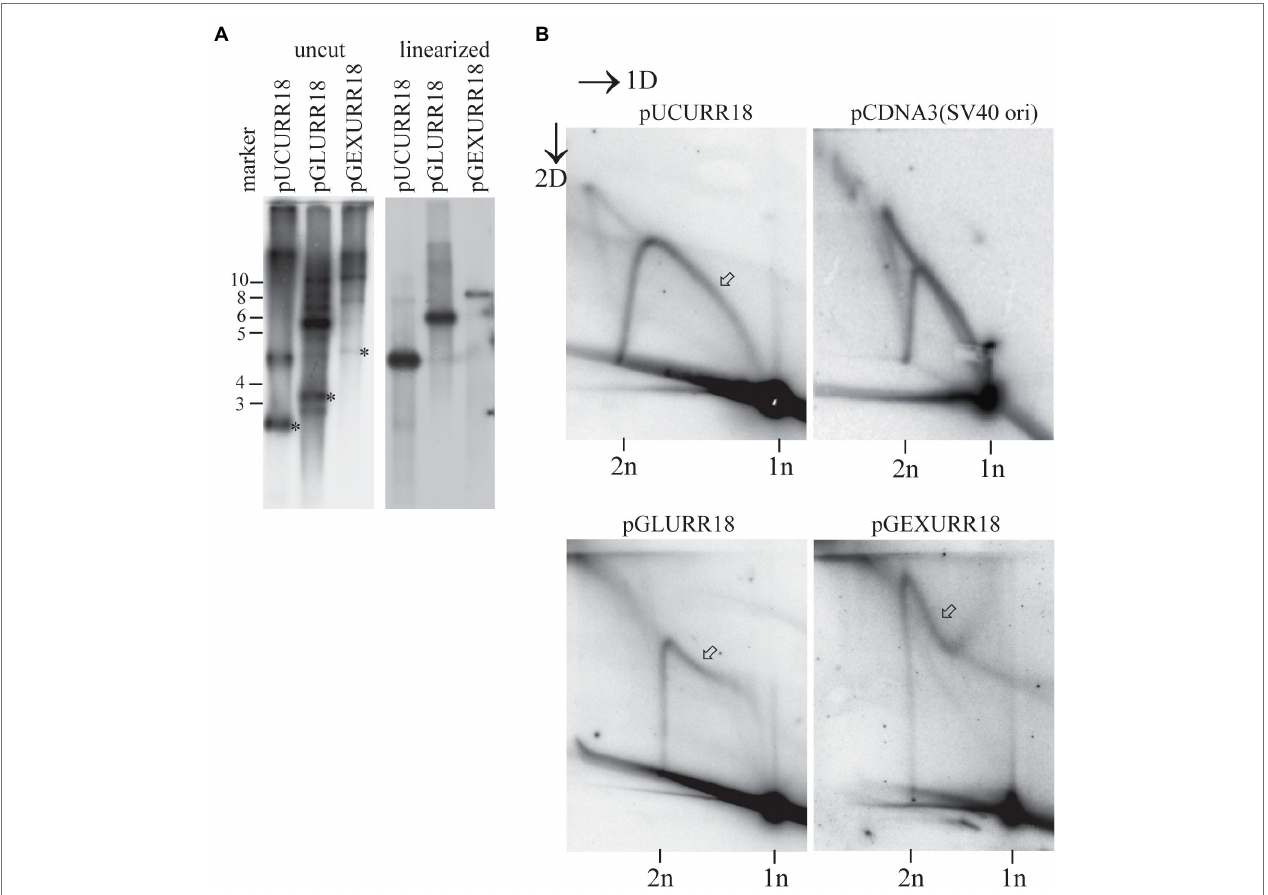
FIGURE 5 | Mechanism of replication initiated from the HPV18 ori depends on the size of the replicon. (A) Transient replication of the HPV18 ori harboring replicons with different sizes in the U2OS cells. pUCURR18 (4 kb), pGLURR18 (6 kb), or pGEXURR18 (8,2 kb) were transfected together with the HPV18 E1 and E2 expression vectors into the U2OS cells. Episomal DNA was extracted 72 h after the transfection, digested with replicon non-cutter (left panel) or single cutter enzyme (right panel), combined with DpnI to digest the non-replicated plasmids, resolved in 0.8% agarose gel and analyzed by SB. Asterisks represent migration of the monomeric closed circular forms of the respective replicons. (B) Neutral-neutral 2D analysis of the replication intermediates arising from the HPV18 harboring replicons of different sizes during the transient replication in the U2OS cells and the SV40 origin containing pCDNA3 replicon in Cos1 cells. The replication intermediate structure that varies between different HPV replicons is indicated with an